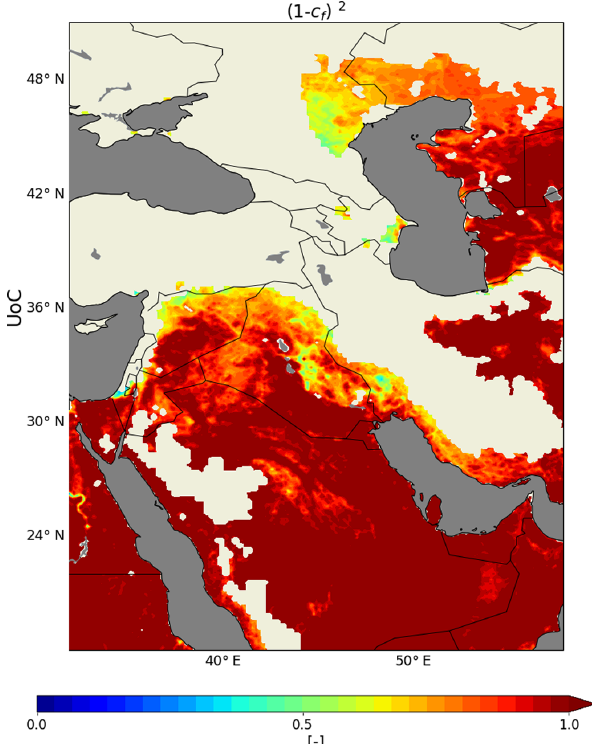
Figure 12. The UoC vegetation correction function, squared to ac- count for the application of the multiplier in both the saltation and emission flux calculations. Areas of dark gray are water bodies, and areas void of color are areas masked out for vegetation in the source strength